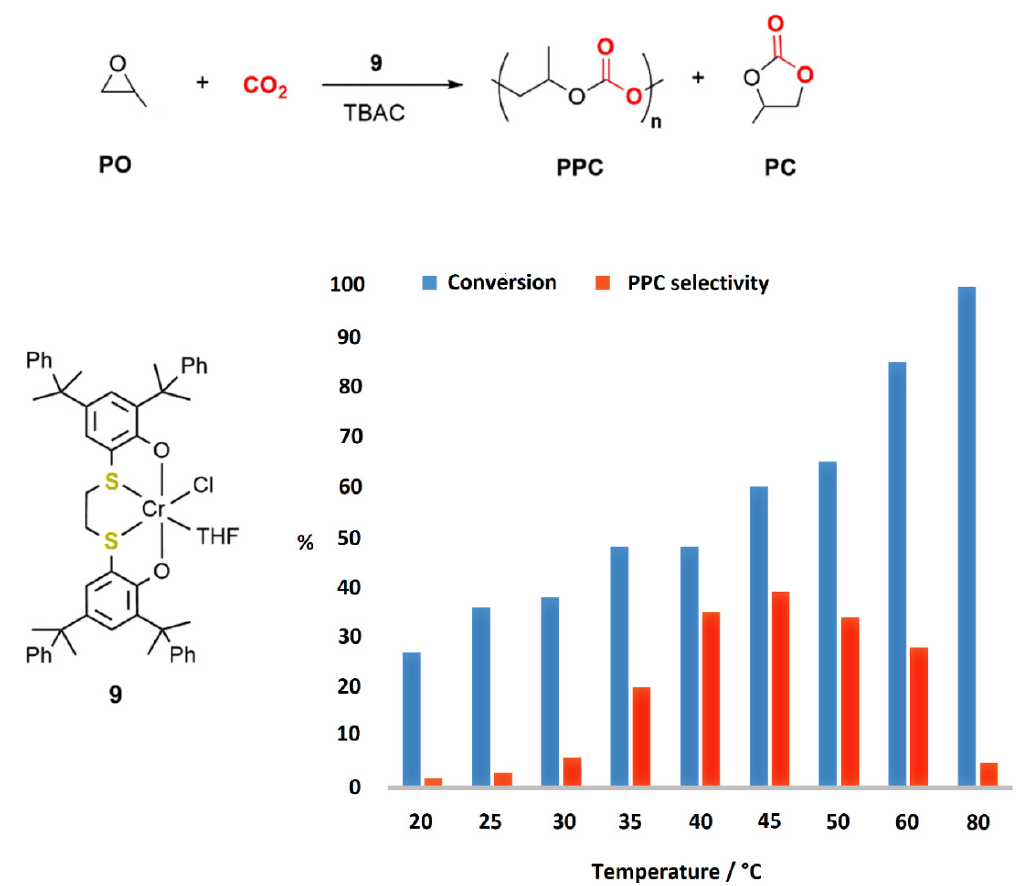
Figure 10. Coupling of PO and CO 2 catalyzed by the chromium(III)-[OSSO] catalyst 9 [61]. Reprinted with permission from ref. 61. Copyright (2020) John Wiley and Sons.